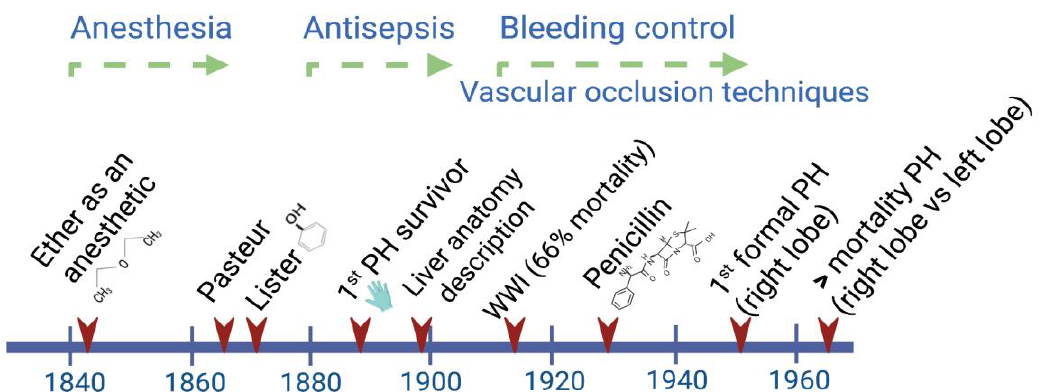
Figure 1. Main advances through the early history of liver surgery have involved interdisciplinary work. By the time Lagenbunch managed to achieve patient survival following a partial hepatectomy (PH), antiseptic procedures including the use of gloves resulted in a greater chance of success. At the beginning of the modern period after World War II, the better control of hemorrhages significantly contributed to a reduction in the mortality rate after right/left liver resections [4].